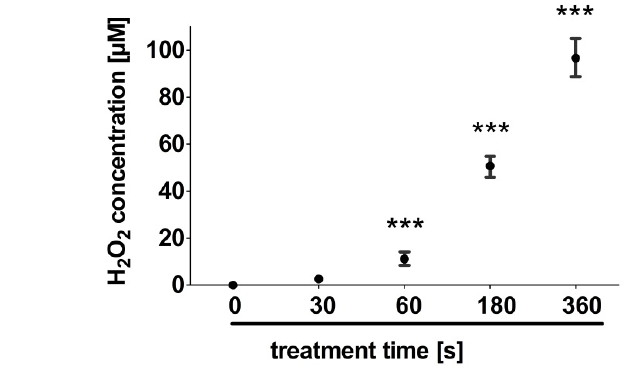
Figure 4 : Flow cytometry analysis of caspase 3 positive cells after indirect plasma treatment. Percentages of caspase 3 positive monocytes were plotted according to plasma treatment time. 100 μM